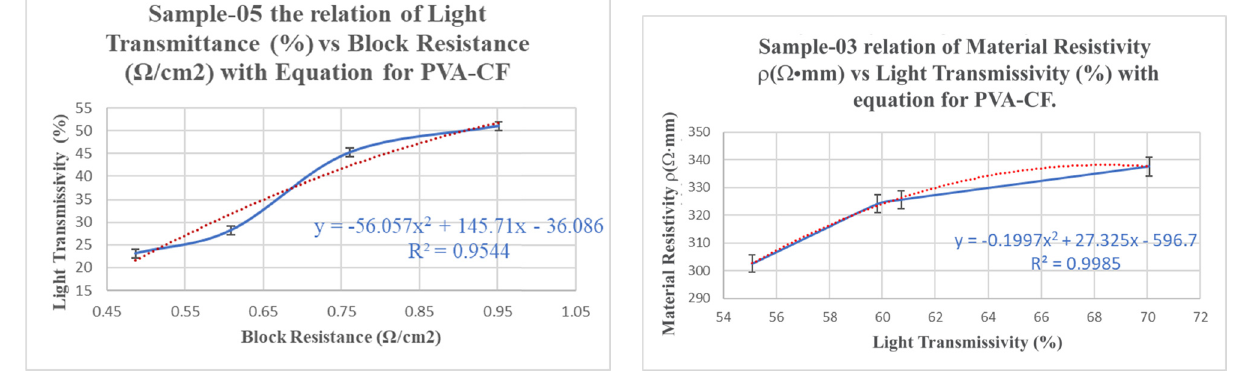
Figure 28: Sample - 03 ( CF:PVA = 0.3:30 ) material resistivity ρ ( Ω mm ) versus light transmittance ( % ) with equation for PVA - CF. The dotted lines represent the polynomial fi tted curve and the linear fi